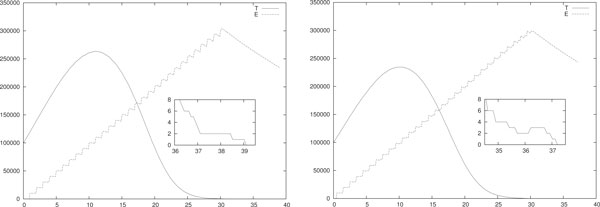
Single run, combined immunotherapies. Single-run of synchronous (left) and asynchronous (right) combined impulsive IL-2 and ACI daily immunotherapies. The asynchronous delivery is a shift of 0.5 days. In (left) ui = 106 for i = 1, . . . , 30 and in (right) wi = 104 for i = 1, . . . , 30. In both cases T(0) = 105, E(0) = I(0) = 0 and pE = 20 · 0.1245. All the other parameters are as in Table 3.